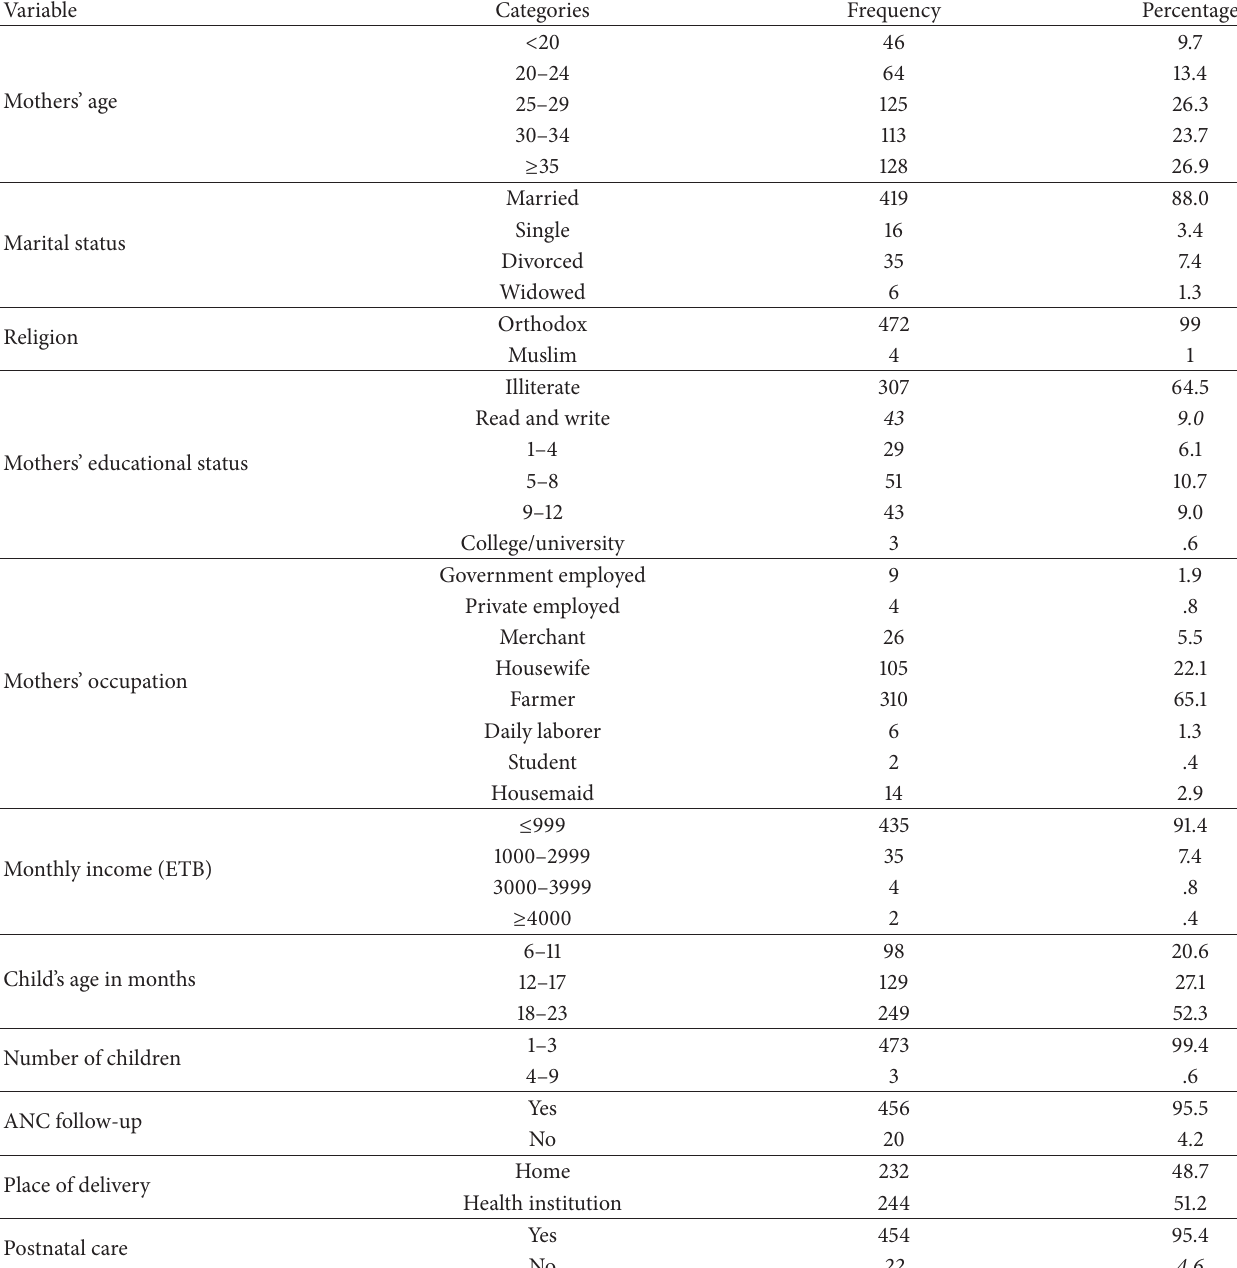
Table 1: Sociodemocratic, obstetric, and health related variables of mothers who had children aged 6–23 months ( 𝑛 = 476 ) in Lasta